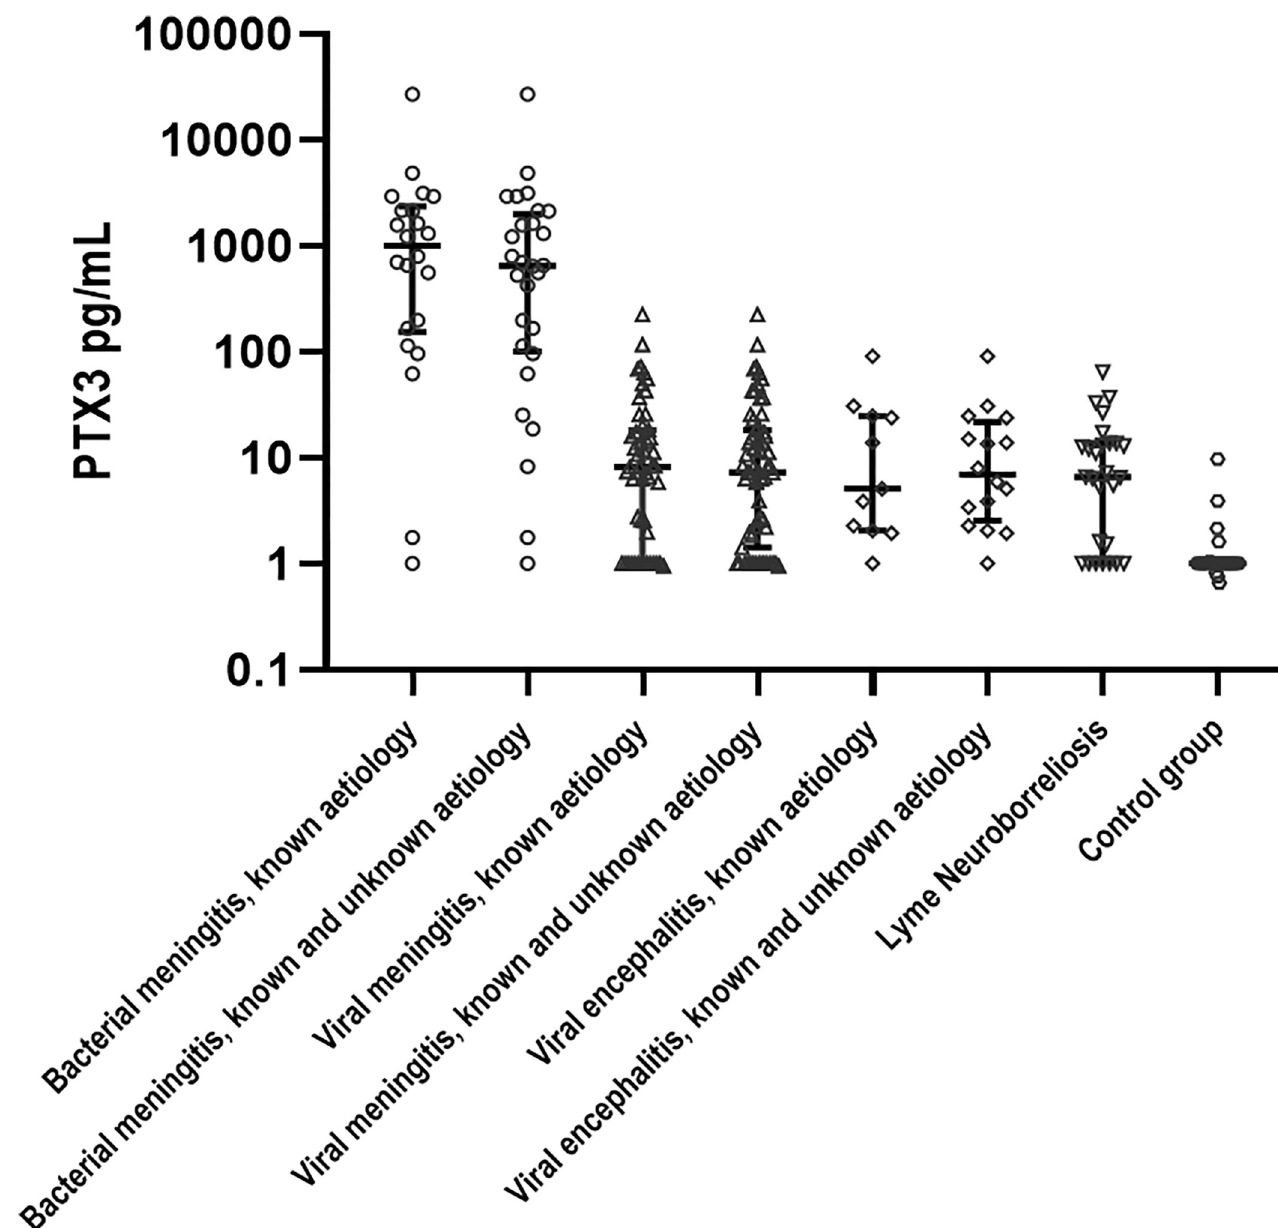
Fig 1. Scatter dot plot of PTX3 concentration in the CSF. Error bars indicate IQR.